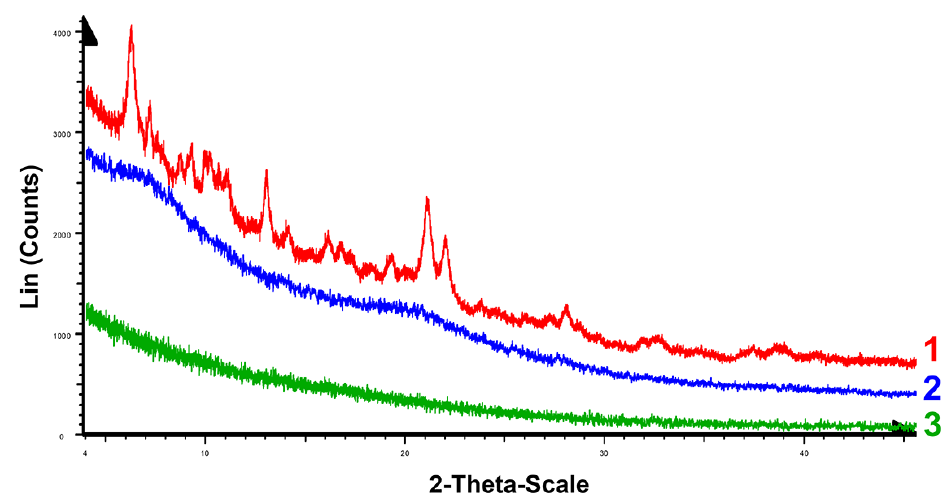
Figure 3. Experimental PXRD powder diffraction patterns of Cu 4 I 4 L 2 complex powder (1) and dried Cu 2 I 2 L 3 colloids (2). Curve 3 corresponds to the background scattering of a standard silicon wafer.